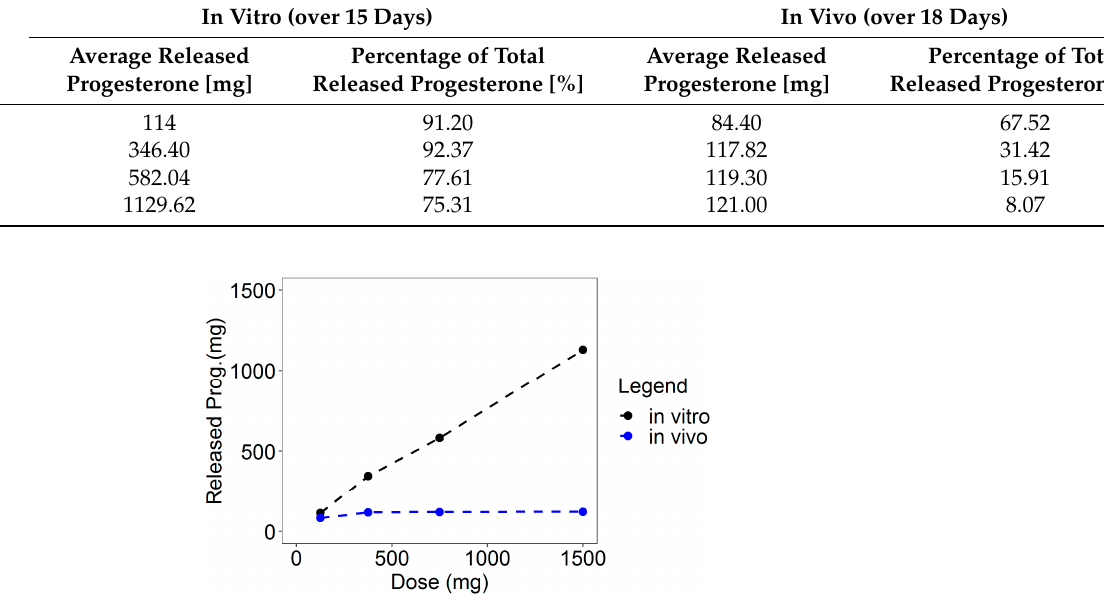
Figure 1. Comparison between the average total amounts of in vitro and in vivo-released proges- terone.